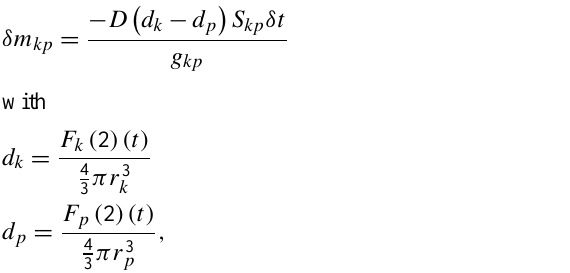
Figure 1: Biological model